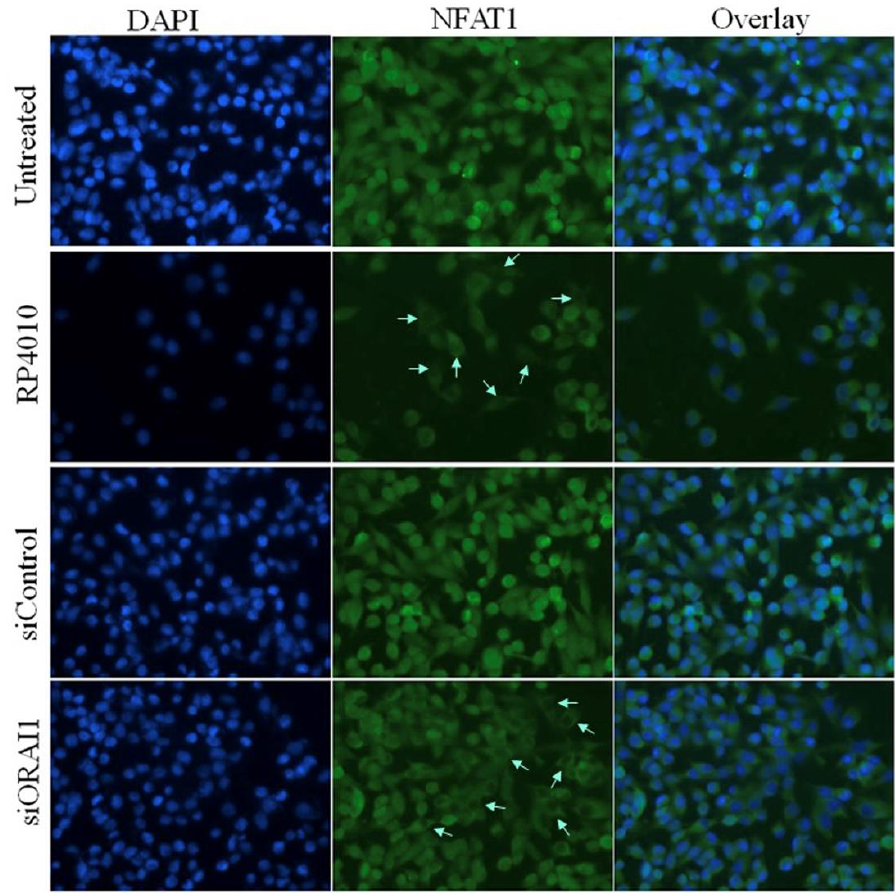
Figure 3. RP4010 impairs the nuclear translocation of NFAT1. MiaPaCa-2 cells were grown on chambered slides and treated with RP4010 (50 µM) for 24 h. Also, MiaPaCa-2 cells having ORAI knock down (siORAI) or its respective control (siControl) were similarly cultured, but received no treatment. Immunofluorescence analysis for NFAT1 nuclear translocation was performed as described in Methods and images were captured at 40 × magnification. Arrows in the images indicate the impairment of the relocation of NFAT in the nucleus.